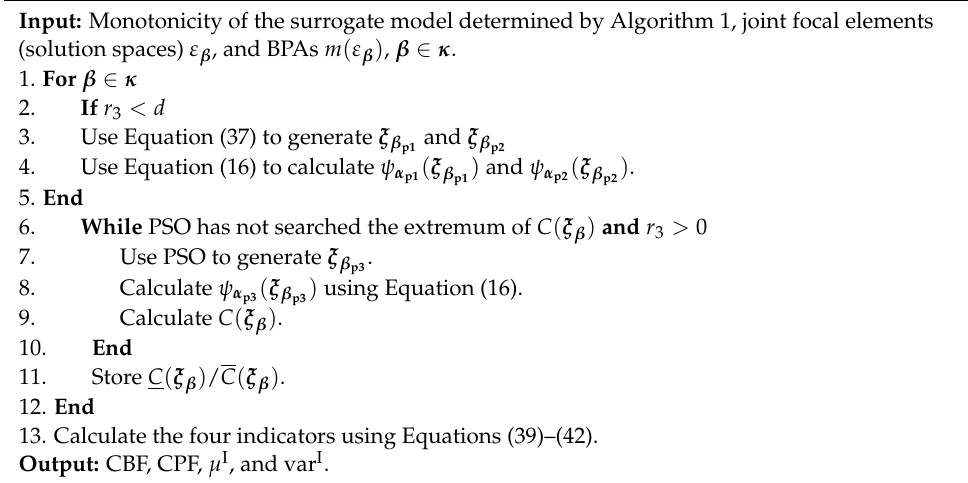
Algorithm 2 Solution-space-reduction-based evidence theory method